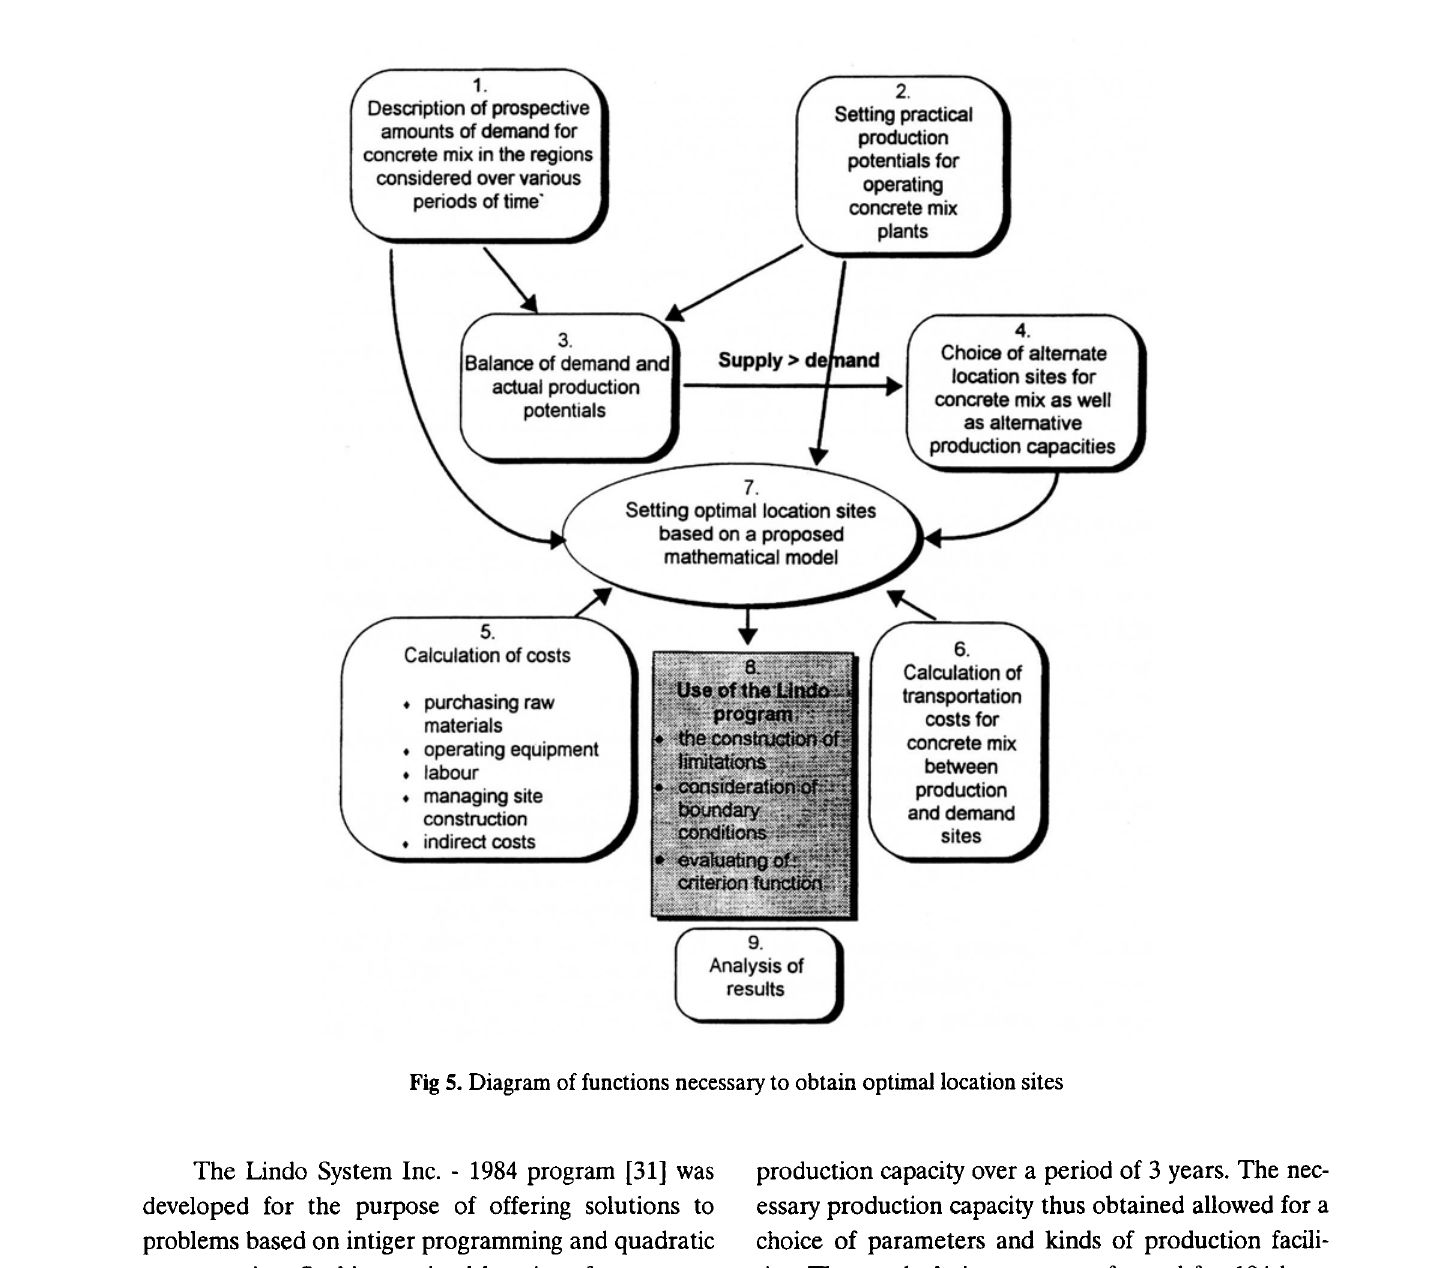
Fig 5. Diagram of functions necessary to obtain optimal location